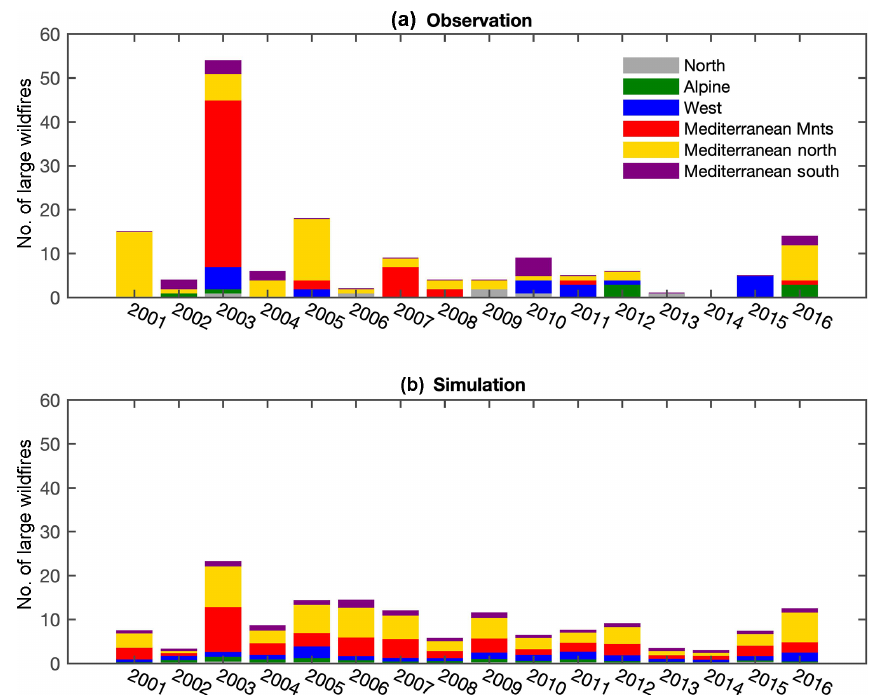
Figure 6. Observed (a) and simulated (b) total number of large wildfires ( > 100ha) per year in each environmental region. Mnts is mountains.